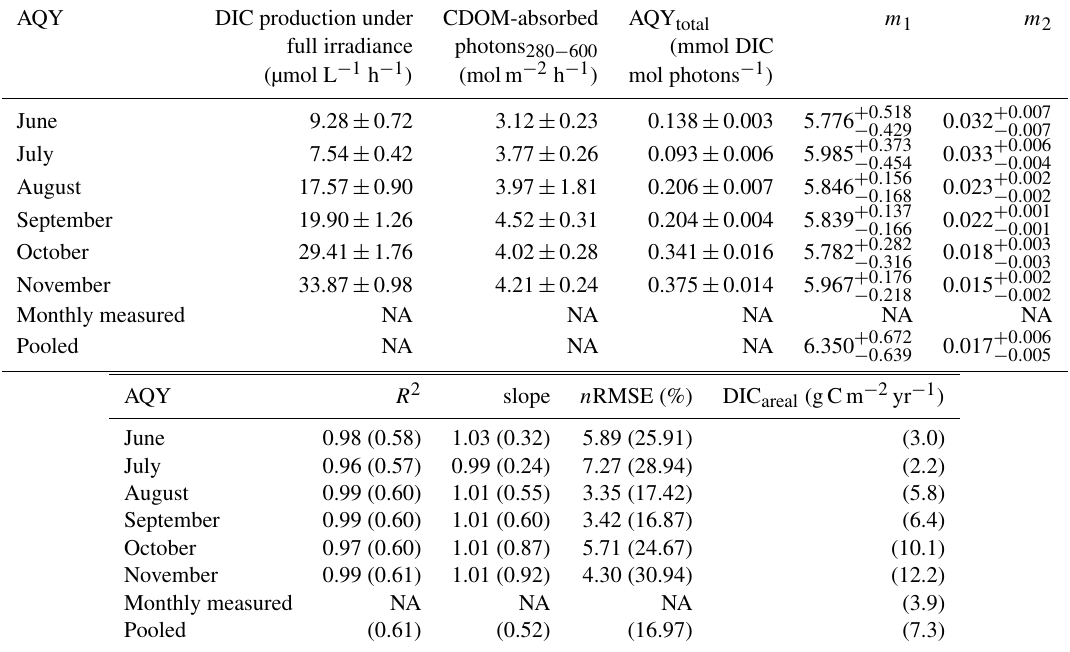
Table 3. Mean ( ± SE) photochemical DIC production under the full irradiance spectrum in the solar simulator, and absorbed photons as well as the total AQY in the wavelength range 280–600nm; parameter estimates for the fitted AQY spectra (Eq. 2), information on performance to reproduce the observations ( R 2 , regression slope and n RMSE) and areal photochemical DIC production in 2014 using the respective AQY spectra. Values in parentheses give diagnostics and simulation results when single AQY spectra were used to predict photochemical DIC production observed during all six irradiation